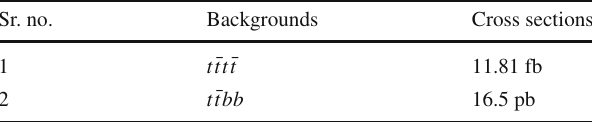
Table 1 The simulated cross sections for the irreducible SM back- grounds for the hadronic decay channel in the four top final state Sr. no. Backgrounds Cross